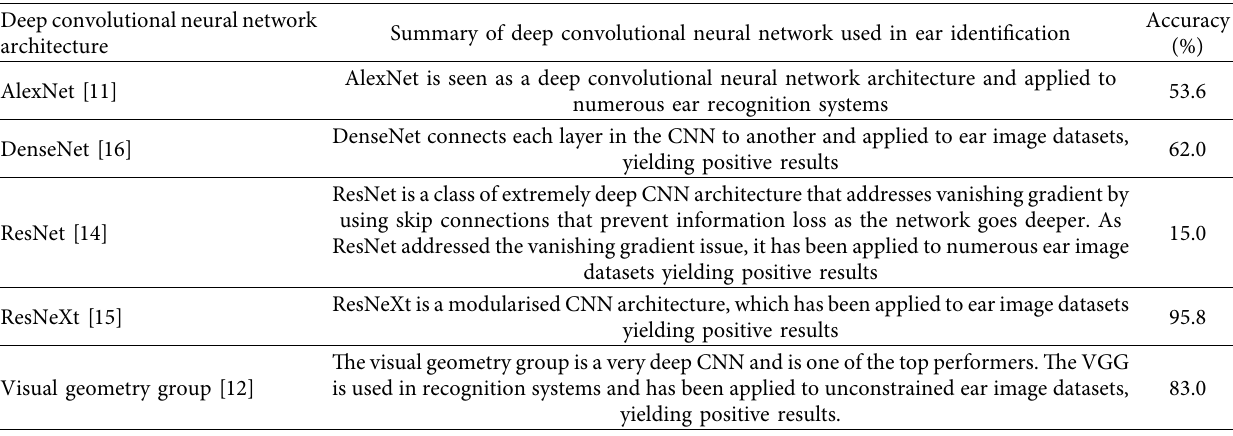
Table 2: Summary of the deep convolutional neural network architecture used for ear